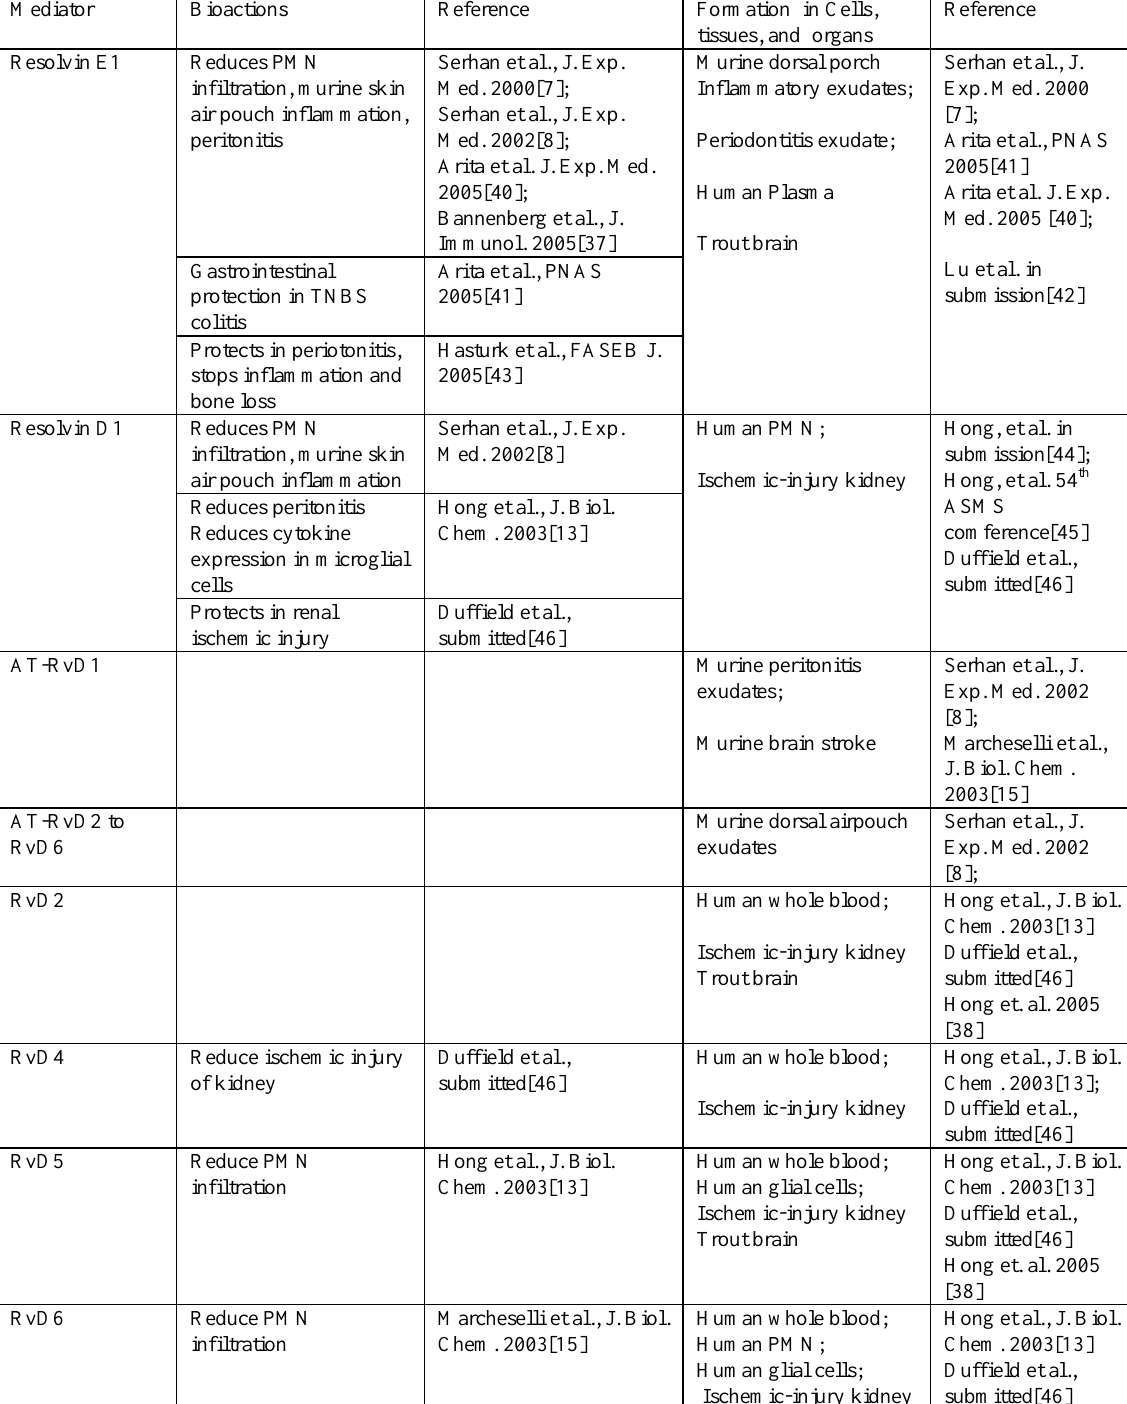
Resolvins and Protectins: Bioactions in Animal Disease Models and Formation in Cells,